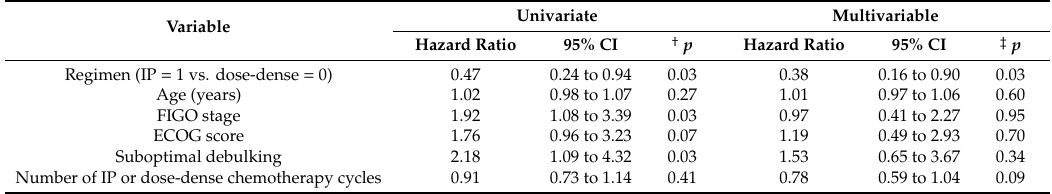
CA-125 = cancer antigen 125, CI = confidence interval, ECOG = Eastern Cooperative Oncology Group, FIGO = The International Federation of Gynecology and Obstetrics, IP = intraperitoneal. † Univariate Cox proportional-hazards model. ‡ Multivariable Cox proportional-hazards model. Multivariable Cox proportional-hazards model also revealed that IP chemotherapy was an independent predictor of OS (hazard ratio = 0.23, 95% CI = 0.07 to 0.79, p = 0.02, Table 3). In addition, the number of IP or dose-dense chemotherapy cycles (hazard ratio = 0.66, 95% CI = 0.47 to 0.94, p = 0.02) was another independent predictor of OS (Table 3). Table 3. Cox proportional-hazards model to predict overall survival ( n = 50). Table 3. Cox proportional-hazards model to predict overall survival ( n = 50). Univariate Multivariable Univariate Multivariable Variable Variable Hazard Ratio 95% CI † p Hazard Ratio 95% CI ‡ p Hazard Ratio 95% CI † p Hazard Ratio 95% CI Regimen (IP = 1 vs. dose-dense = 0) 0.35 Regimen (IP = 1 vs. dose-dense = 0)